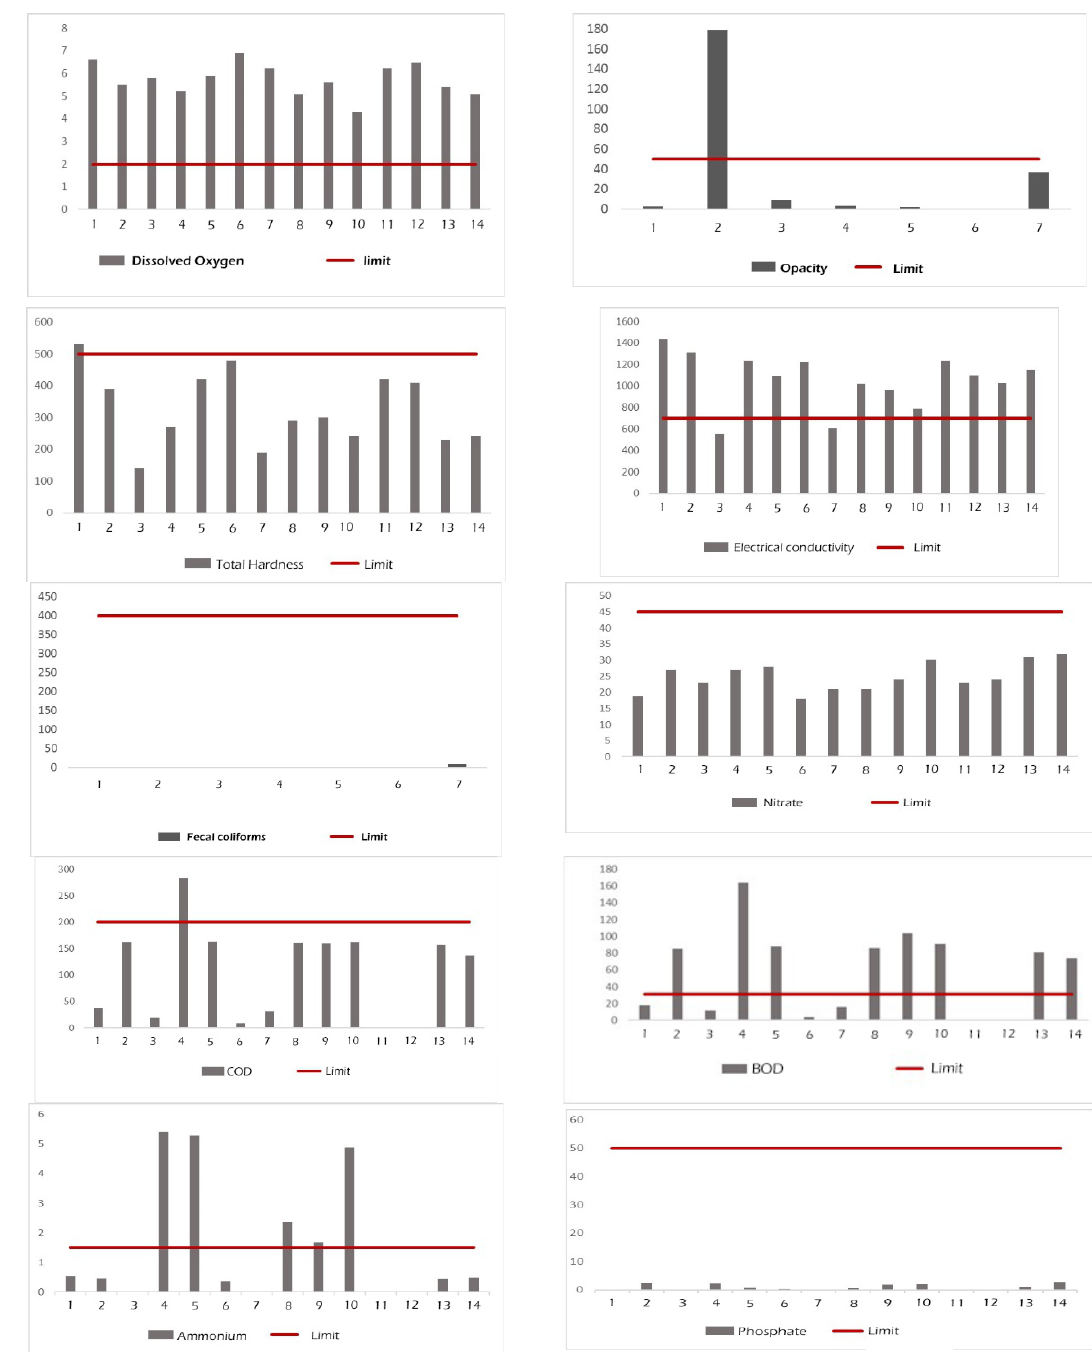
Figure 3 . Comparison of measured parameters of conventional surface water contamination with